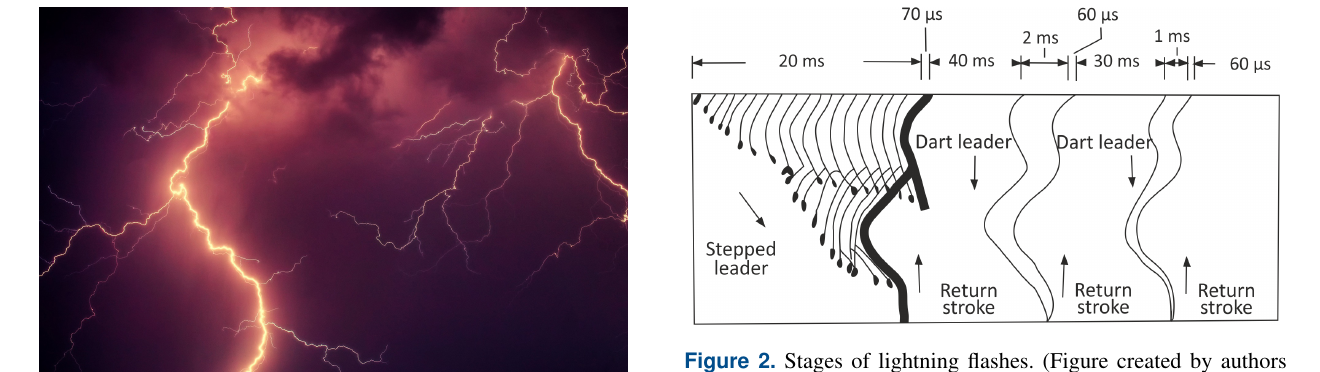
Figure 2. Stages of lightning flashes. (Figure created by authors based on